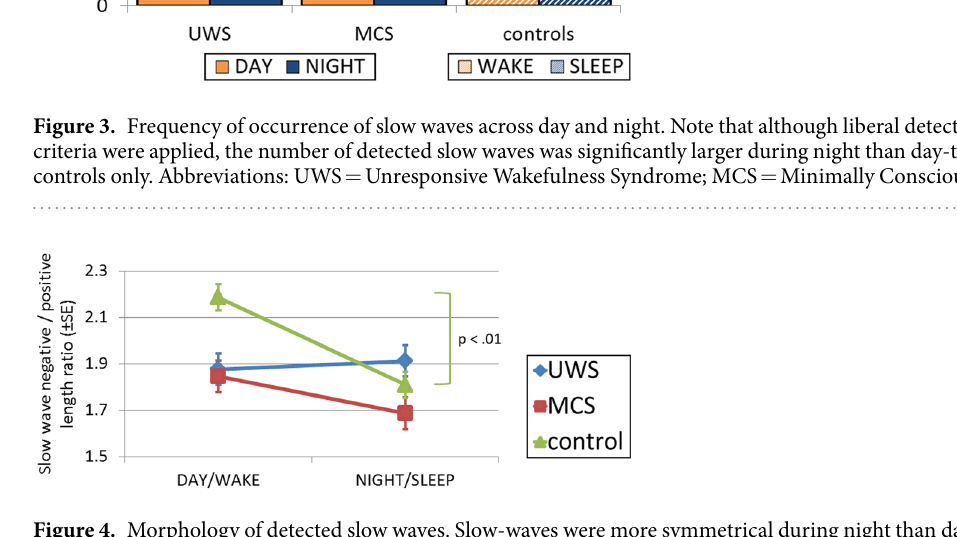
Figure 4. Morphology of detected slow waves. Slow-waves were more symmetrical during night than day-time in controls only. A similar day to night-time change was observed in MCS patients; however the difference did not reach the level of statistical significance. Abbreviations: UWS = Unresponsive Wakefulness Syndrome; MCS = Minimally Conscious State.